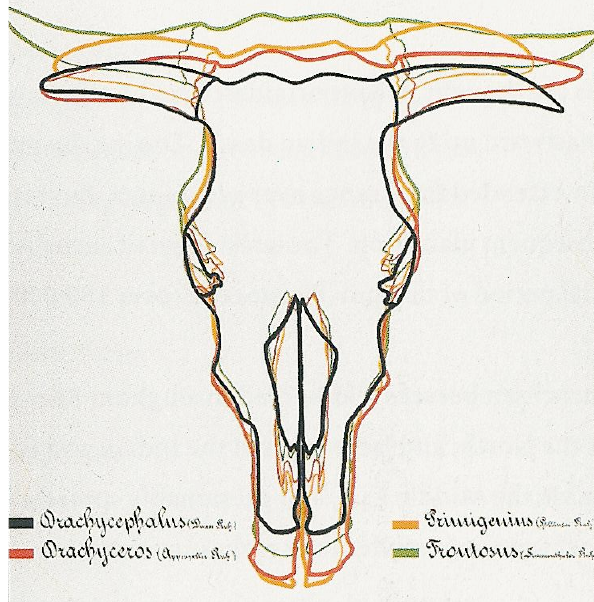
Figure 1. Basic types of cattle skulls, according to Wilckens [26]. Black, brachycephalus ; orange, primigenius ; red, brachyceros ; green, frontosus .